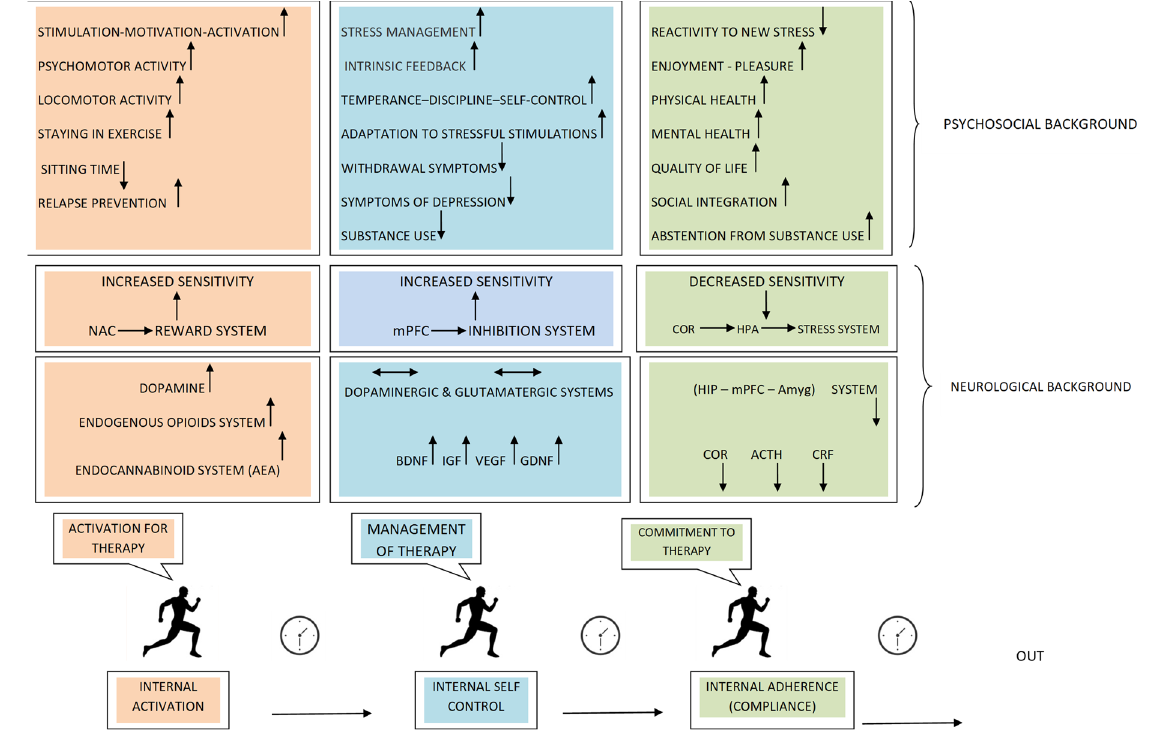
Figure 1. Physical exercise has beneficial effects on both the biological and psychosocial underpin- nings of addiction, acting initially as a factor of internal activation and management and eventually as a factor of commitment and adherence to therapy. This approach suggests a sequential (temporal) consolidation of the functions of exercise in favor of gradual disengagement from addiction. The sequence of events follows the pattern of Internal activation—Self-regulation—Commitment, even- tually resulting in the modification of molecular and behavioral aspects of opioid addiction. Physi- cal exercise has the following effects: no change/balance, upregulation, and downregulation.